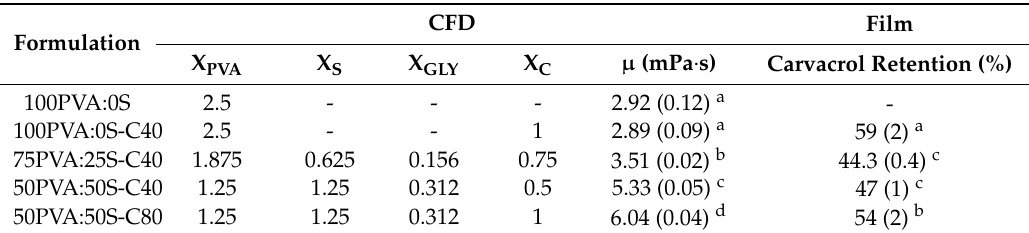
Table 1. Mass fraction (X) ( g / 100) and viscosity of the di ff erent components in each coating forming dispersion (CFD) and carvacrol retention percentage in the dry films. Mean values (and standard deviation). (S: Starch; PVA: Polyvinyl alcohol; Gly: Glycerol; and C: Carvacrol). CFD Film Formulation X PVA X S X GLY X C µ (mPa · s) Carvacrol Retention (%)